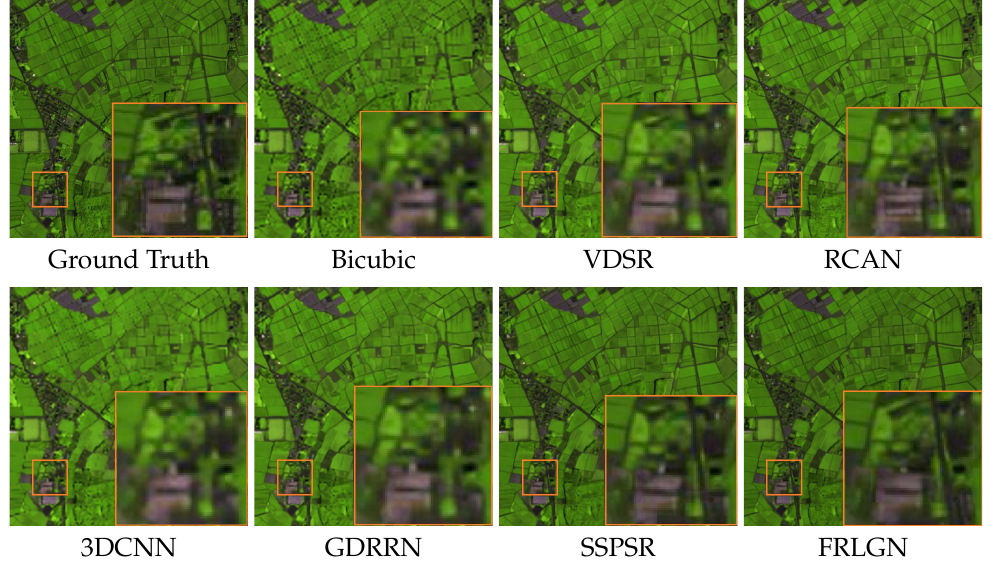
Figure 7. A reconstructed hyperspectral image from the Chikusei testing dataset with the scale factor Figure 7. The fourth reconstructed hyperspectral image from the Chikusei testing dataset with the 4, in which the bands 70-100-36 is treat as R-G-B. scale factor 4, in which the bands 70-100-36 are treated as R-G-B.